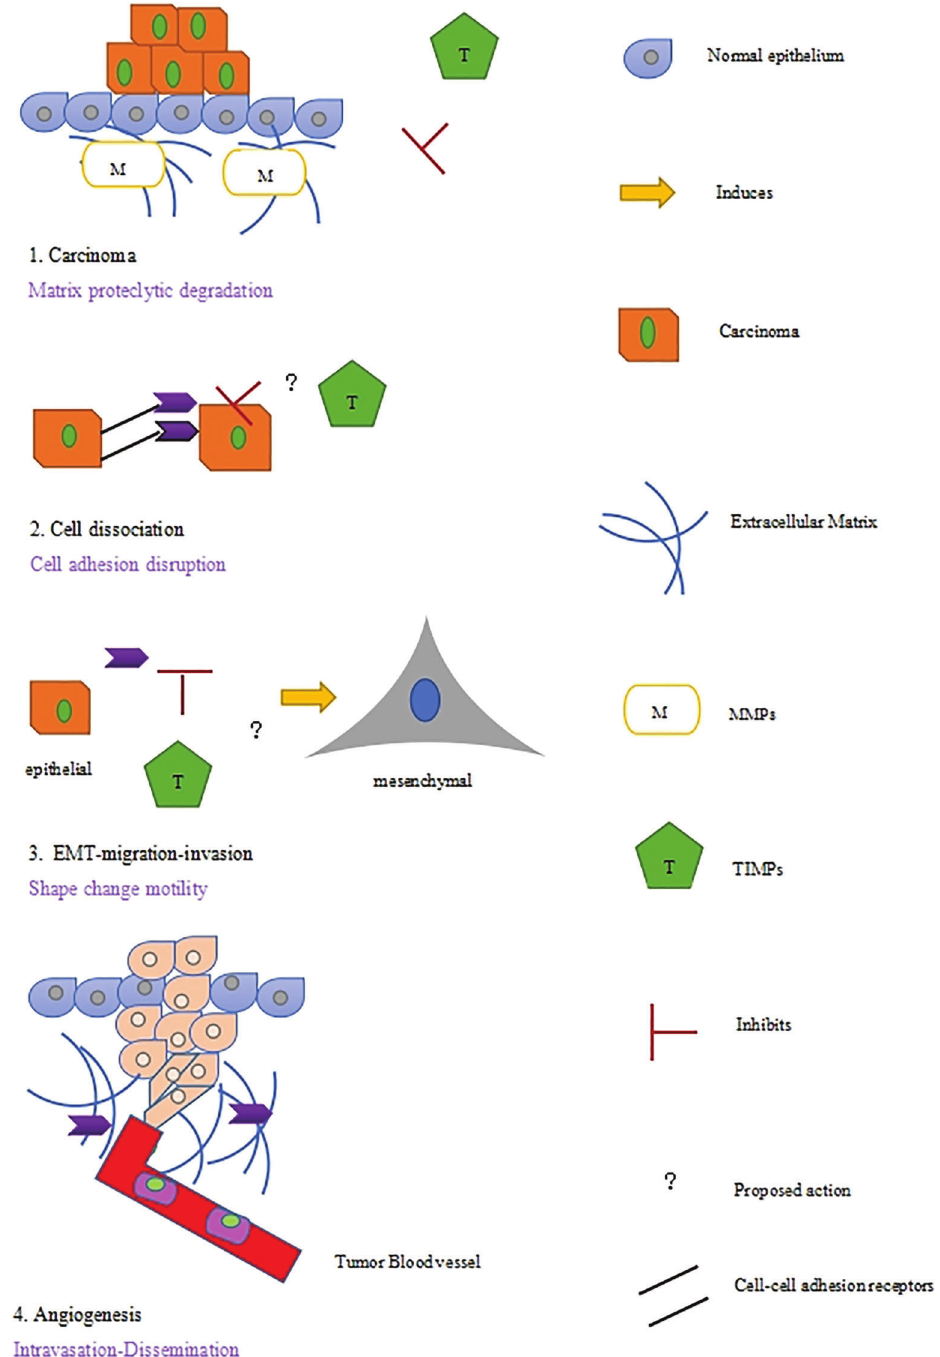
Figure 2. Matrix metalloproteinases (MMPs) and tissue inhibitors of matrix metalloproteinases (TIMPs) input in tumor cell adhesion during different levels of carcinoma progression. The proposed activities of TIMPs need further